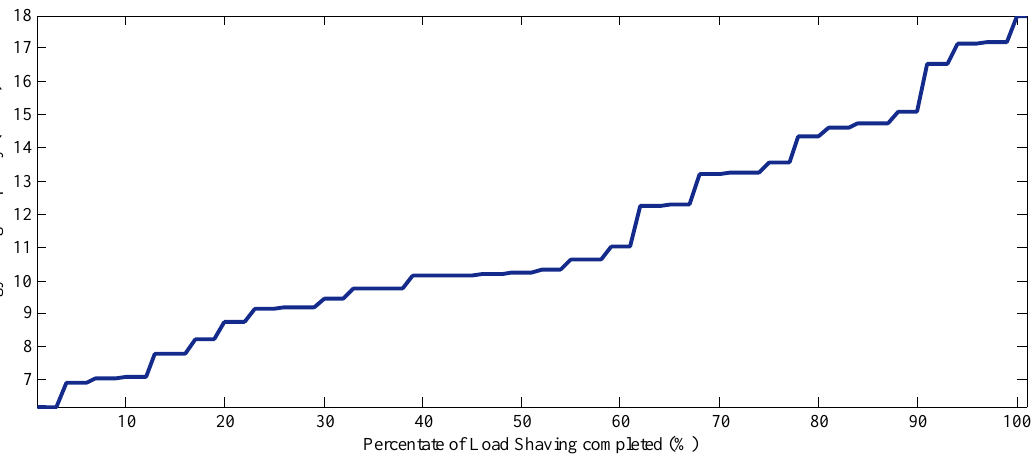
Figure 4. Relationships between BESS capacity and peak load shaving completion